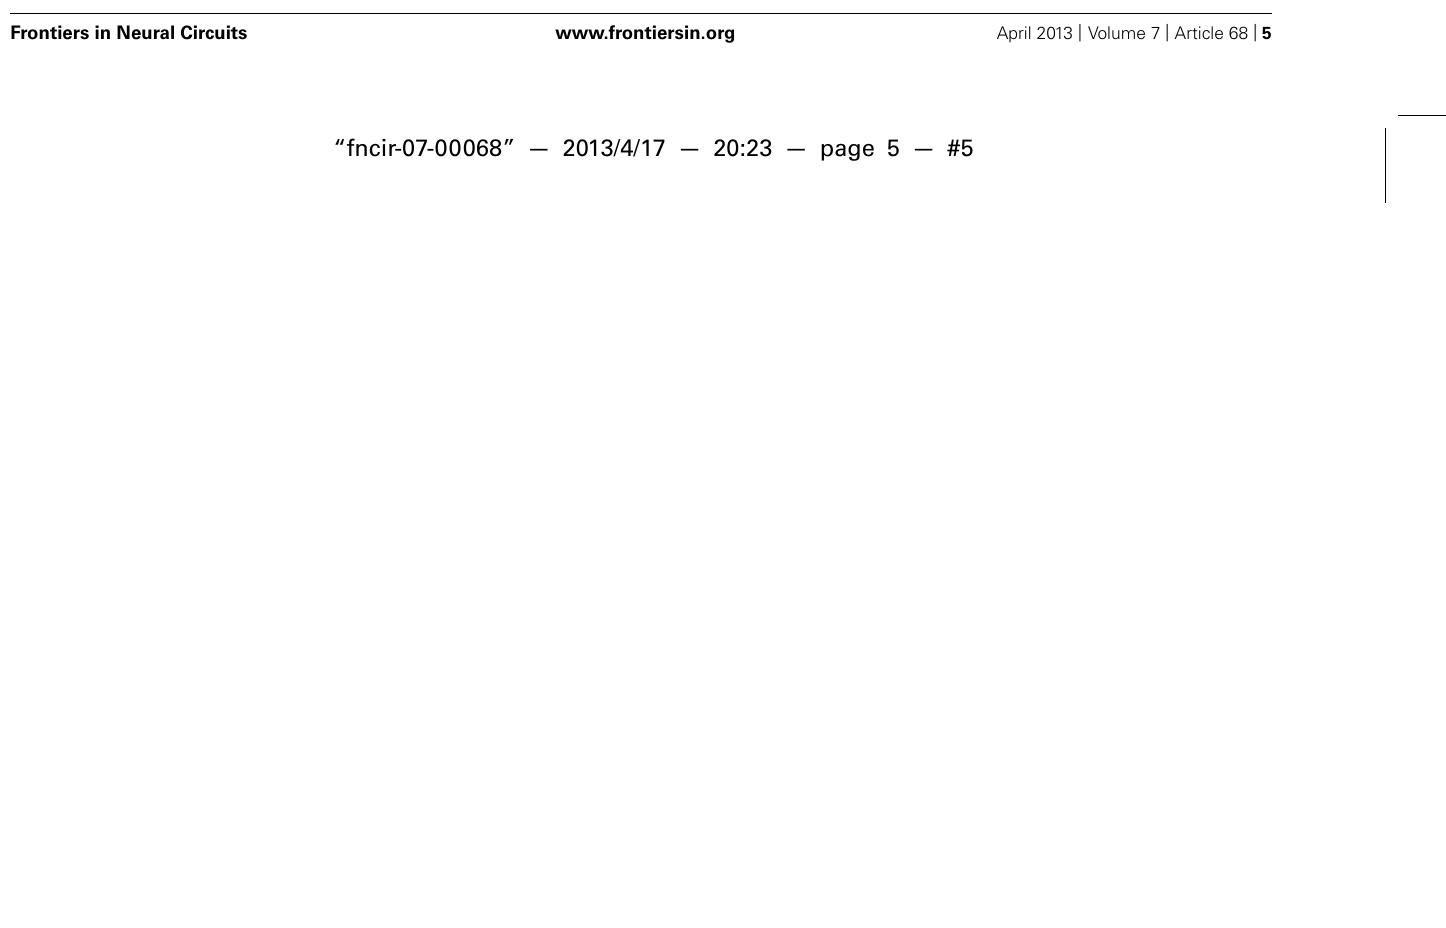
FIGURE 4 | Modulation of response of IC neuron (IC Mdu ) during focal electrical stimulation of the contralateral IC neuron (IC ES ). (A,B) Focal electrical stimulation of one IC ES neuron produced inhibition of two IC Mdu neurons but produced facilitation of another IC Mdu neuron. (C,D) Focal electrical stimulation of another IC ES neuron produced inhibition of all three